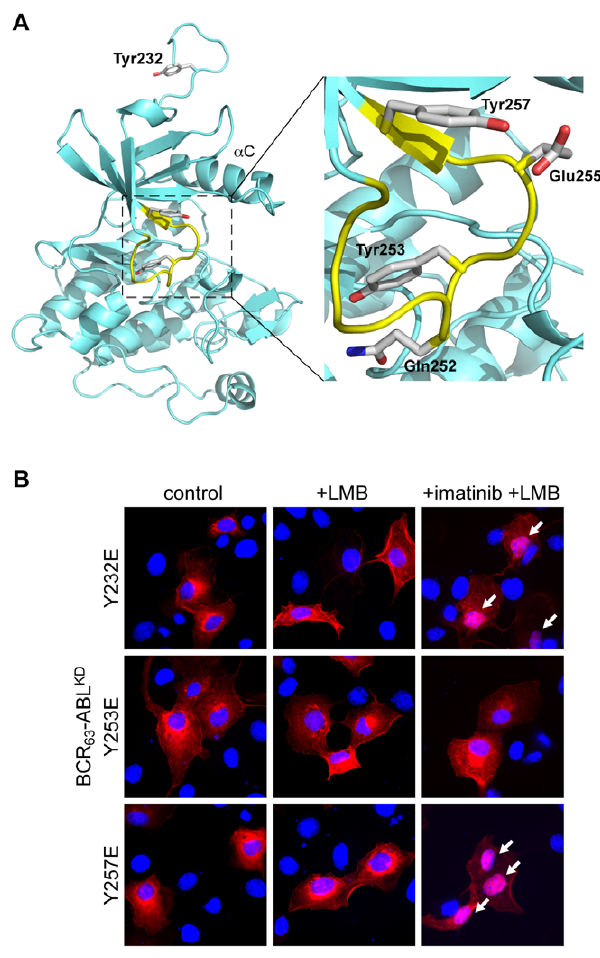
Figure 5. Phosphomimetic mutation of either Tyr232, Tyr253, or Tyr257 blocks nuclear import of kinase-defective BCR 63 - ABL. A : Position of tyrosines 232, 253, and 257 as seen in a crystal structure of the ABL kinase domain bound to imatinib ([31], PDB code 1IEP). The Tyr253 and Tyr257 are in the P-loop (yellow), and are engaged in interactions with other P-loop side chains (Gln252 and Glu255) in this structure. Tyr232 is located in the SH2-kinase linker region and situated right above the kinase N-lobe in this structure. B : BCR 63 -ABL KD , in which either Tyr232, 253 or 257 was mutated to glutamic acid, was transiently expressed in COS cells. The localization of each of these three Y/E-mutant proteins after the indicated treatments with LMB and imatinib was determined by immunofluorescence. Merged images of BCR-ABL staining (red) and DNA (blue) are shown. Cells displaying nuclear staining are marked by the white arrows. doi:10.1371/journal.pone.0017020.g005 (Figure 6F), remains cytoplasmic in the absence of drug treatment (Figure 6D). However, nuclear localization of a fraction of the BCR 63 -ABL F1081E protein was observed following treatment with LMB alone without the need of kinase inhibition by imatinib (Figure 6D), suggesting that the NLS function in BCR 63 - ABL F1081E is partially restored despite autophosphorylation (Figure 7A). The BCR 63 -ABL D 1080 mutant behaved similarly to the F1081E mutant in that its nuclear localization can be stimulated by treatment with LMB alone (Figure 6E). The behavior of these two mutant proteins, with defects of helix-3 in the FABD, suggested that binding to F-actin might be responsible for the inhibition of nuclear import. At odds with this interpretation, however, was the behavior of two other FABD